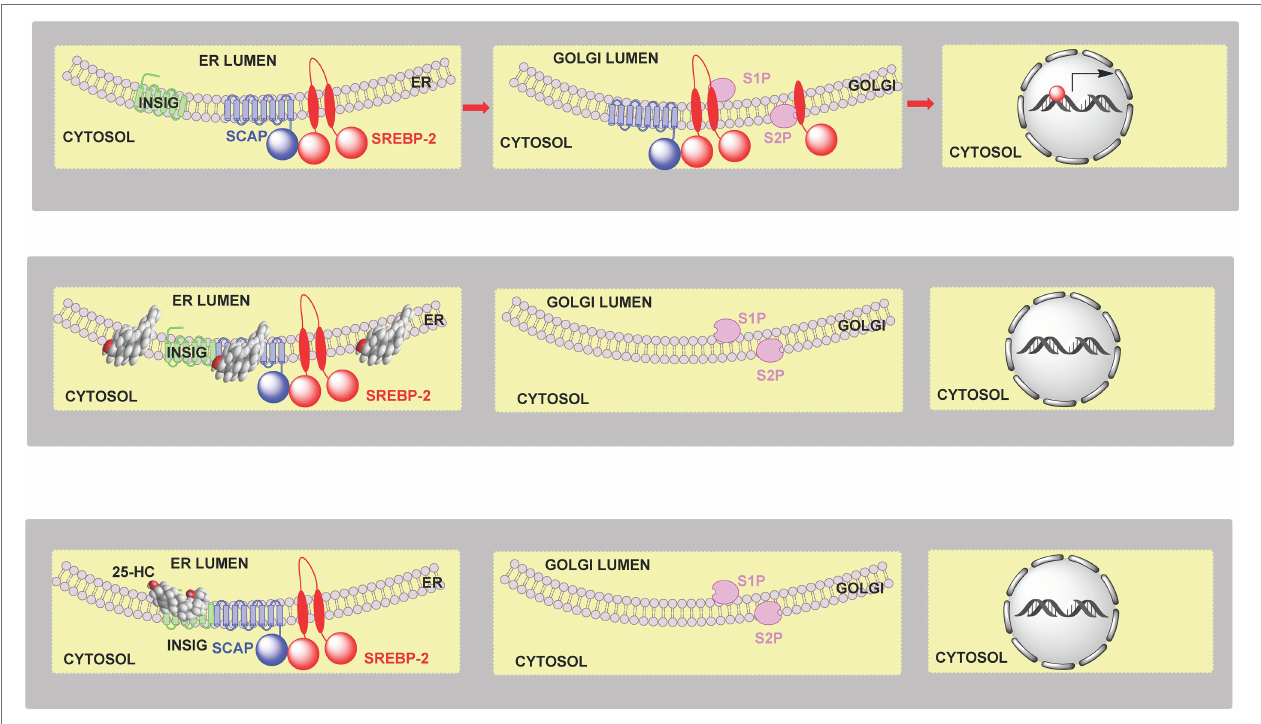
FIGURE 2 | Cartoon representation of the regulation of cholesterol biosynthesis by SREBP-2. Upper panel , left to right, SCAP transports SREBP-2 from the endoplasmic reticulum to the Golgi, it is then processed to the active nuclear form which translocates to the nucleus and activates target gene transcription. Central panel , when cholesterol levels are elevated (>5 mole % endoplasmic reticulum lipids), cholesterol binds to SCAP, which then binds to INSIG retaining the SCAP-SREBP-2 complex in the endoplasmic reticulum preventing transport to, and formation of the active transcription factor, in the Golgi. Lower panel , 25-HC can bind to INSIG tethering the SCAP-SREBP-2 complex in the endoplasmic reticulum and restraining SREBP-2 transport and processing. SREBP-2 target genes include ACAT2 , HMGCS , HMGCR , MVK , PMVK , MVD , IDI1 , GGPS1 , FDPS , FDT1 , SQLE , LSS , CYP51A1 , TM7SF2 , MSMO1 (SC4MOL) , NSDHL , HSD17B7 , EBP , SC5D , DHCR7 , DHCR24 , LDLR , INSIG1 , and STARD4 (Horton et al., 2002,